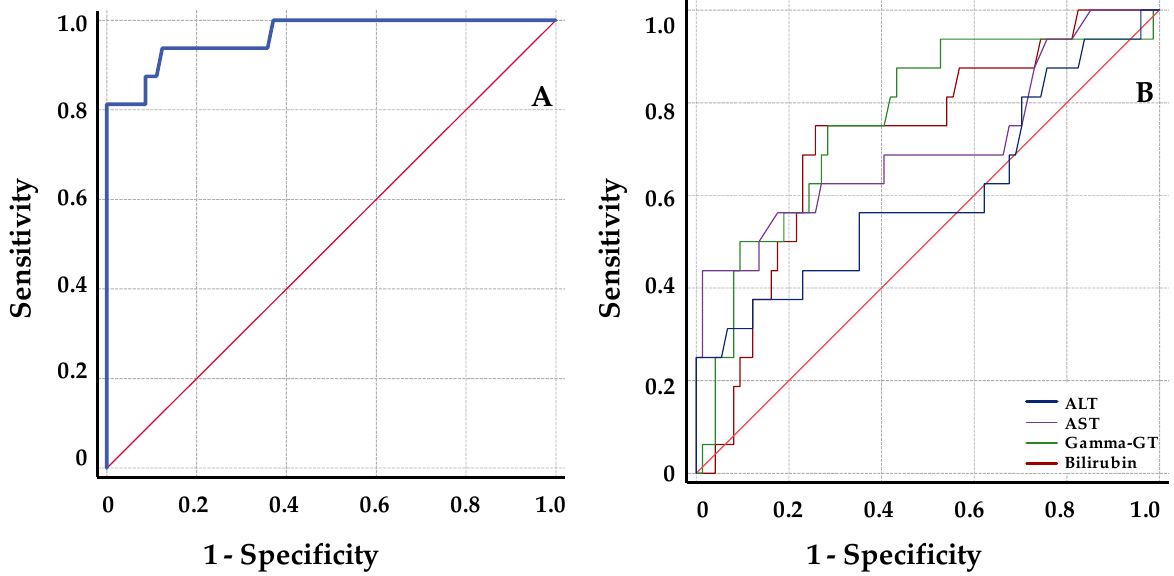
Figure 5. ROC curves for discrimination of rejection from stable samples. ( A ) ROC curve for serum ds-cfDNA percentage values; ( B ) ROC curves for serum liver function markers. Of the 100 samples included, 84 were baseline samples and 16 were samples of patients under BPR. ALT: alanine aminotransferase; AST: aspartate aminotransferase; gamma-GT: gamma-glutamyltransferase.